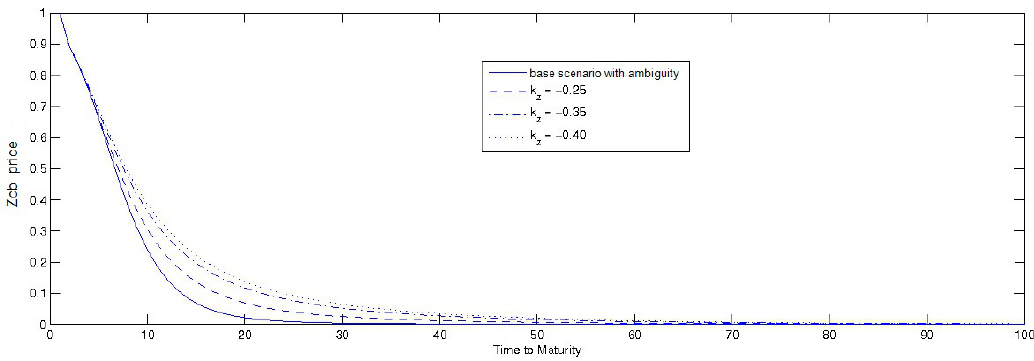
Figure 5. Zero coupon bond price in different hypothetical levels of k z